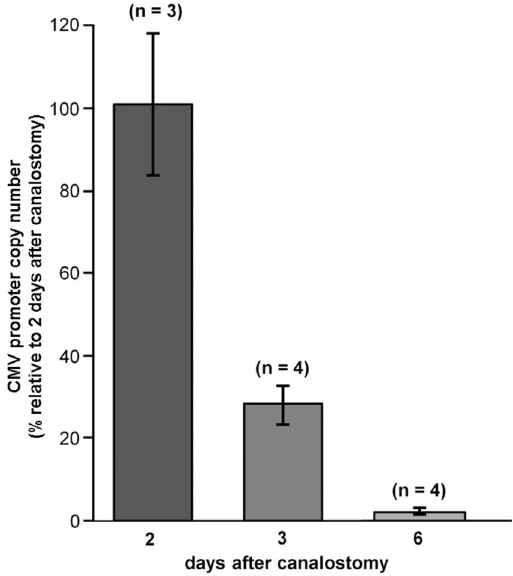
Figure 8. Quantification of BAAV genome following in vivo delivery at P4 via canalostomy to the mouse cochlea. CMV level was measured by q-PCR (see Methods) 2, 3 and 6 days after canalostomy and normalized to the level detected on day 2; error bars represent